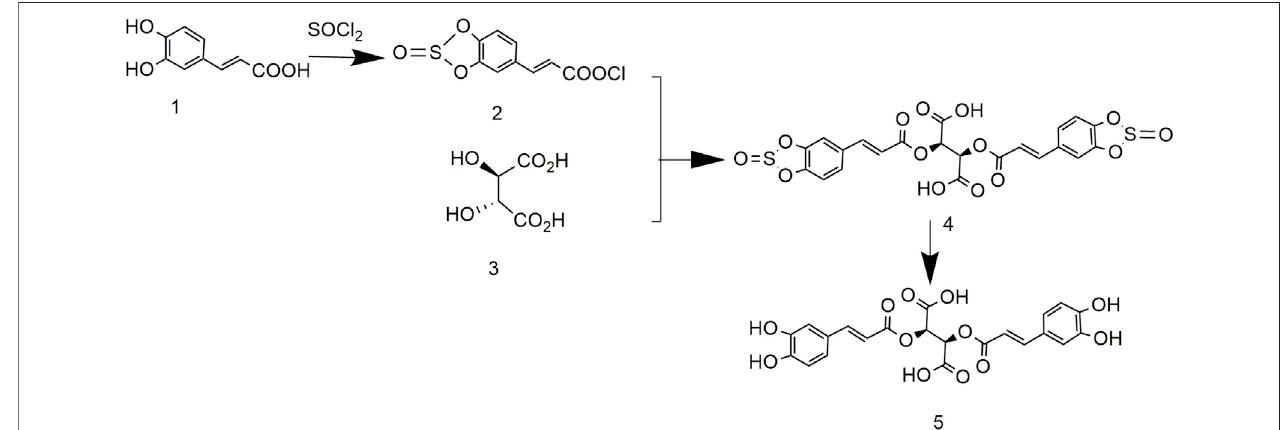
FIGURE 8 | Chemical synthesis pathway 6 of chicoric